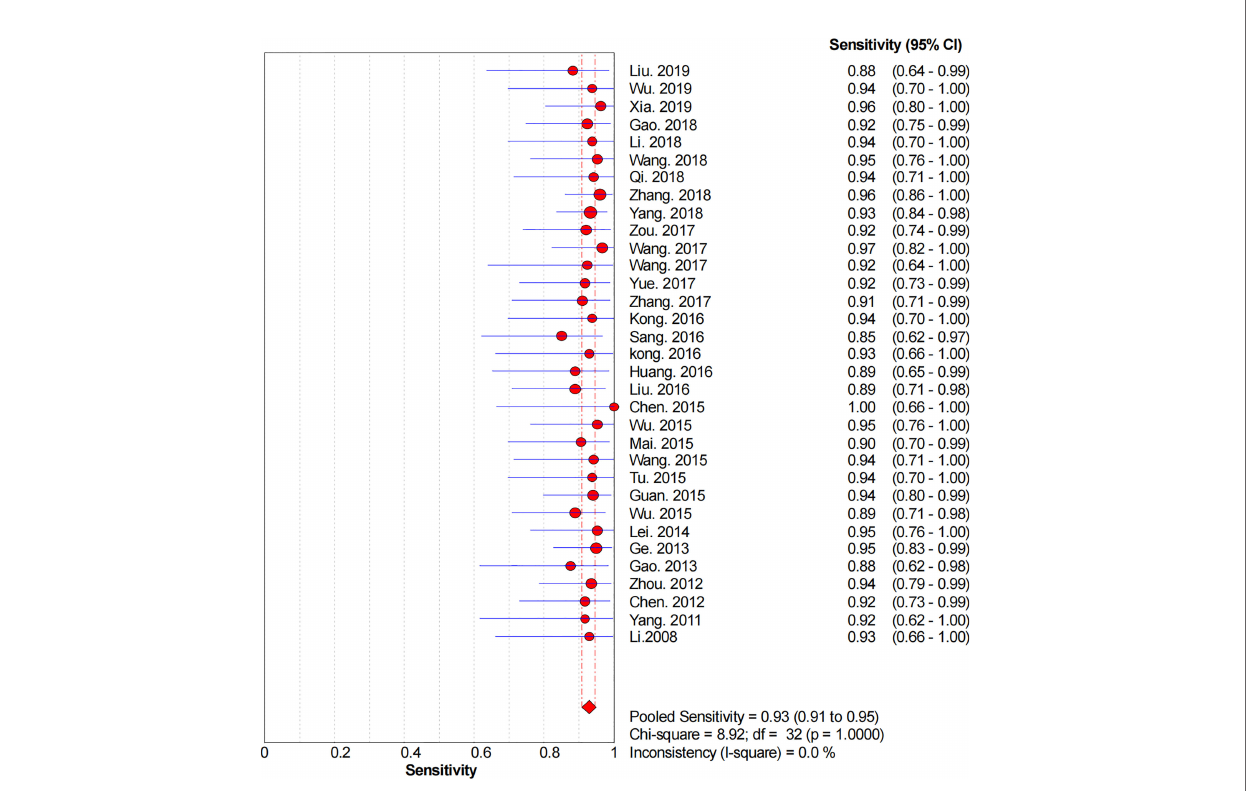
FIGURE 2 | Forest plot of pooled sensitivity of the diagnosis value of CNSs in SLNB of breast cancer. 95% CI, 95% con fi dence